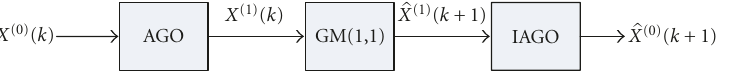
Figure 4: The procedure of simple grey prediction.